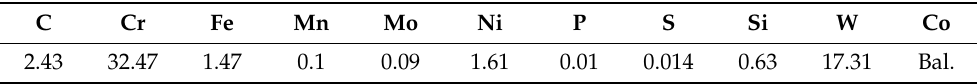
Table 2. Chemical composition of Stellite20 alloy powder (wt.%).